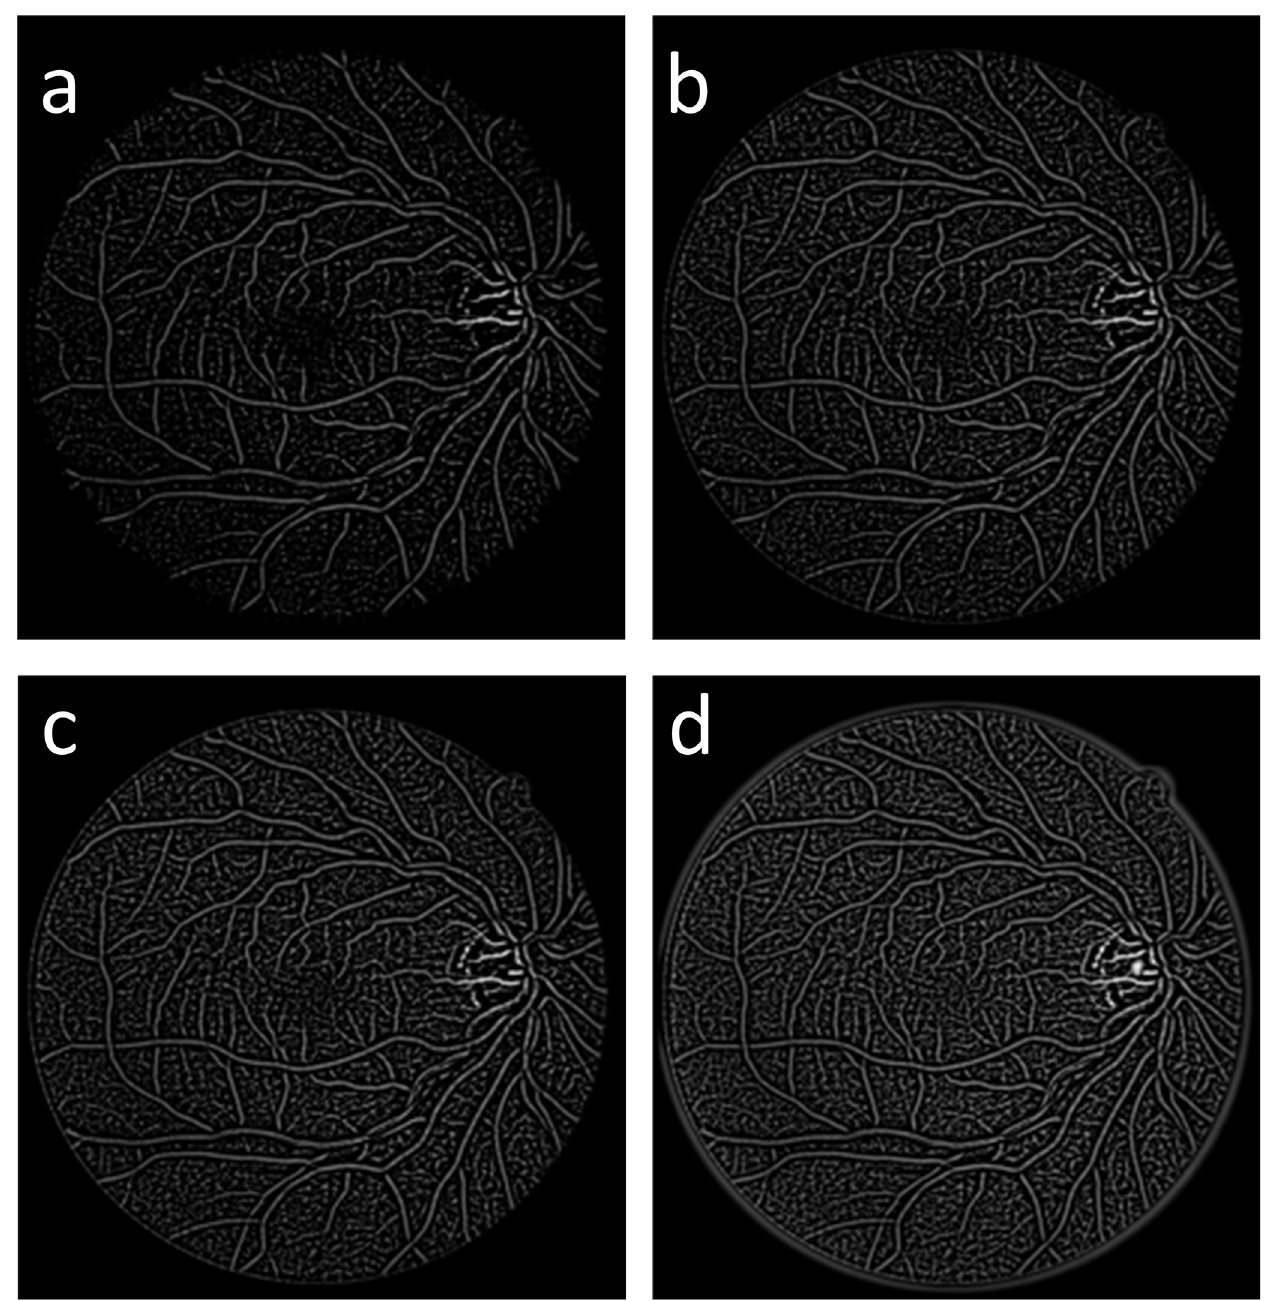
Fig 7. (a-d) Results of the gray-voting algorithm applied to vessel fragment detection with different value of k: (a) k = -10; (b) k = -5; (c) k = -3; and (d) k =